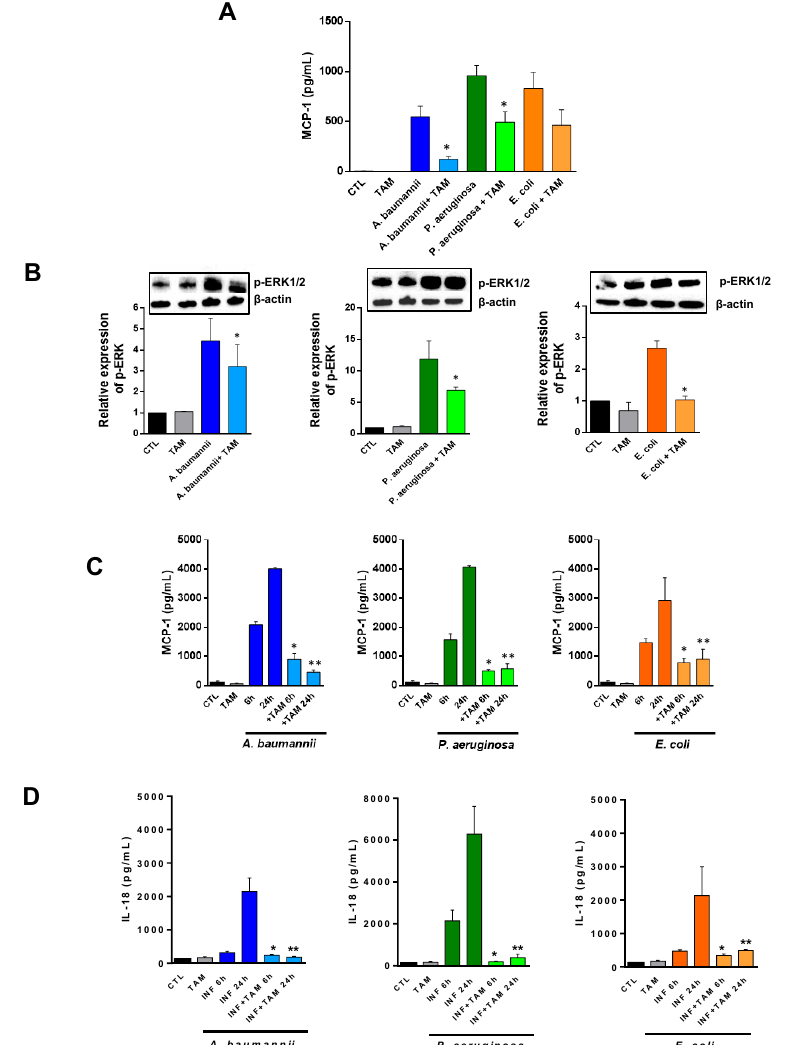
Figure 3. Tamoxifen reduces, after bacterial infection, the release of MCP-1 and IL-18 in vitro and in vivo, and ERK phosphorylation in vitro. ( A , B ) RAW 264.7 cells were treated with 2.5 mg/L of tamoxifen for 24 h and infected with A. baumannii ATCC17978, P. aeruginosa PAO1, or E. coli ATCC25922 strains for 2 h. MCP-1 levels and ERK-phosphorylation were determined by ELISA and immunoblotting assays, respectively. Data are representative of three independent experiments, and expressed as mean ± SEM. ( C , D ) Mice received firstly tamoxifen (80 mg/kg/d, for three days), followed by infection with a minimal lethal dose 100 (MLD100) of A. baumannii ATCC17978, P. aeruginosa PAO1, or E. coli ATCC25922 strains. At 6 and 24 h post-infection, serum was harvested for MCP-1 and IL-18 ELISA assays. Data are representative of six mice per group and are expressed as mean ± SEM. * p < 0.05: treated vs. INF, ** p < 0.05: treated vs. CTL. CTL: non-infected mice. TAM: tamoxifen. INF: infected.